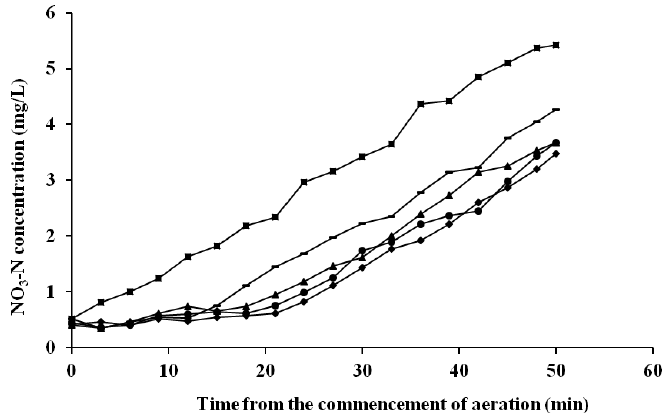
Figure 3. Influence of aeration strategy on partial nitrification ( ■ : 0 min non-aeration duration; -: 10 min non-aeration duration; ▲ : 20 min non-aeration duration; ●: 30 min non-aeration duration; ♦ : 40 min non-aeration duration).